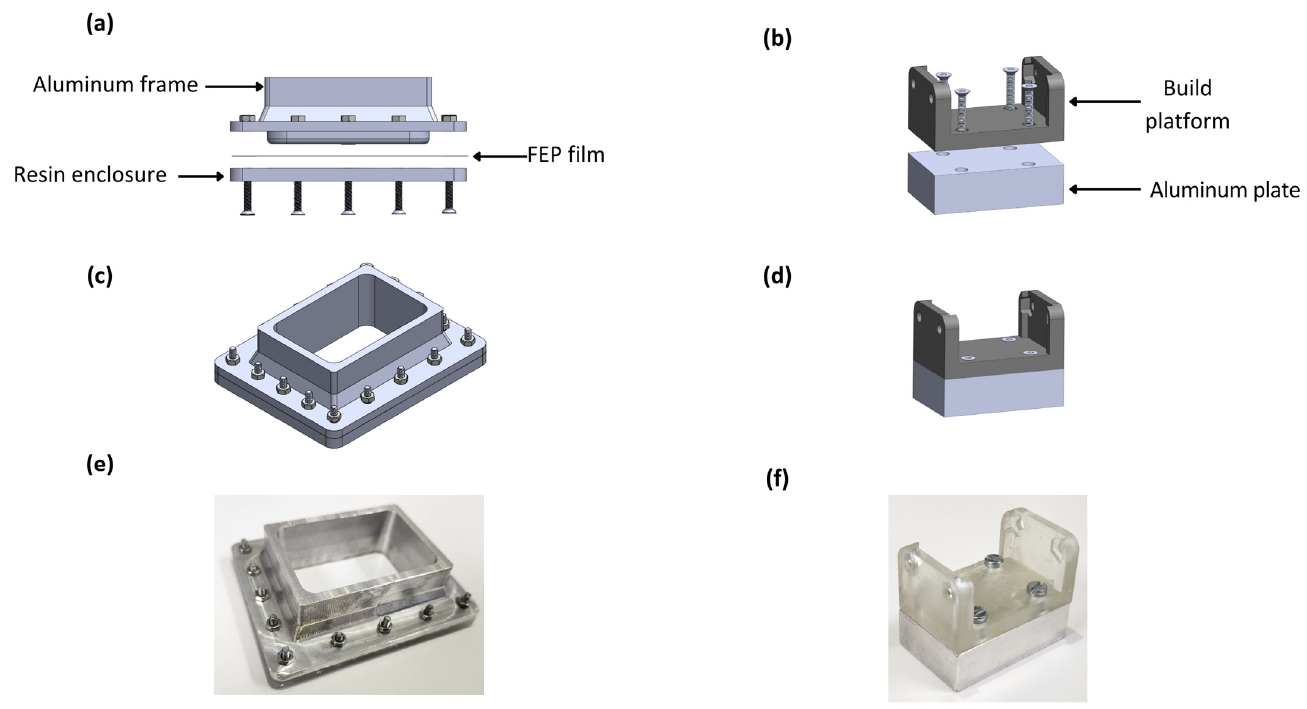
Figure 5. Elements of the bioprinting equipment retrofitting: ( a ) lateral exploded view of bioink container, ( b ) lateral exploded view of build plate, ( c ) isometric view of build plate, ( d ) isometric view of build plate, ( e ) manufactured vat, and ( f ) manufactured building plate.